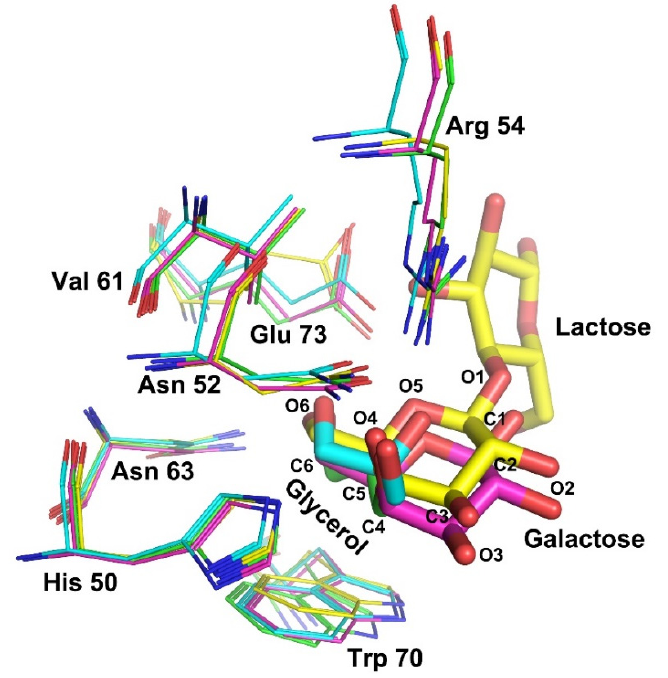
Figure 5. The carbohydrate binding sites of Gal-7 are merged. The residues of ligand-binding sites from structure 1, structure 2, and Gal-7 in complex with galactose (PDB: 2GAL) and Gal-7 in complex with lactose (PDB: 4GAL) are labeled by cyan, green, magenta and yellow, respectively. The positions of residues (His 50, Asn 52, Arg 54, Val 61, Asn 63, Trp 70 and Glu 73) could coordinate with glycerol and lactose. The C and O atoms of glycerol occupy similar sites as C4, C5, C6 and O4, O5, and O6 of galactose.